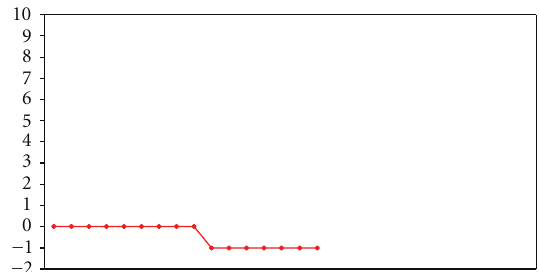
Figure 3: A patient whose symptoms did not change until clinical encounter number 8, then worsened, with no change after